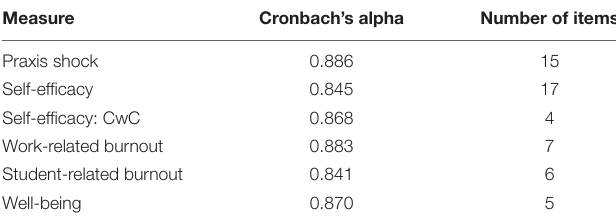
TABLE 1 | Reliability of